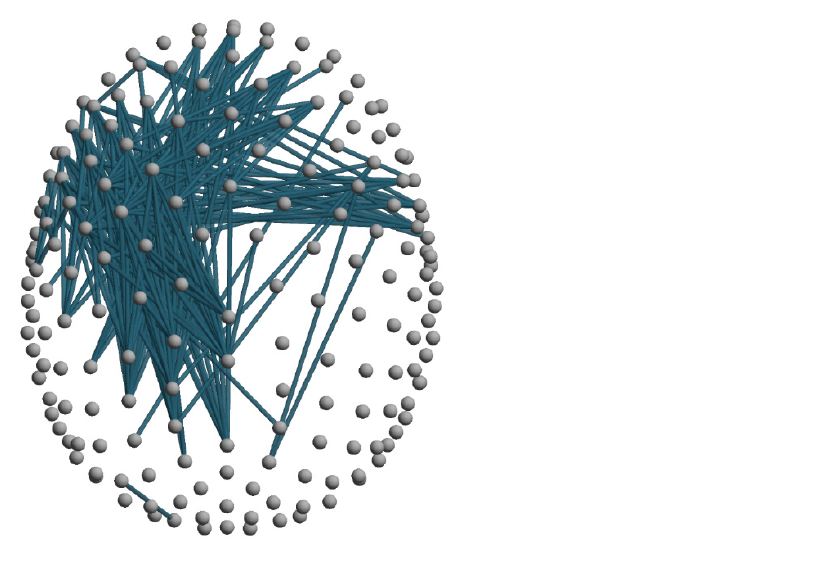
Figure 3. Significant decreases in theta band connectivity are presented for the VH versus RS comparisons (blue lines). The critical t-value (in absolute value) for significance at p = 0.05 is |t| = 3.12 (single threshold tests for the maximum t-statistics).